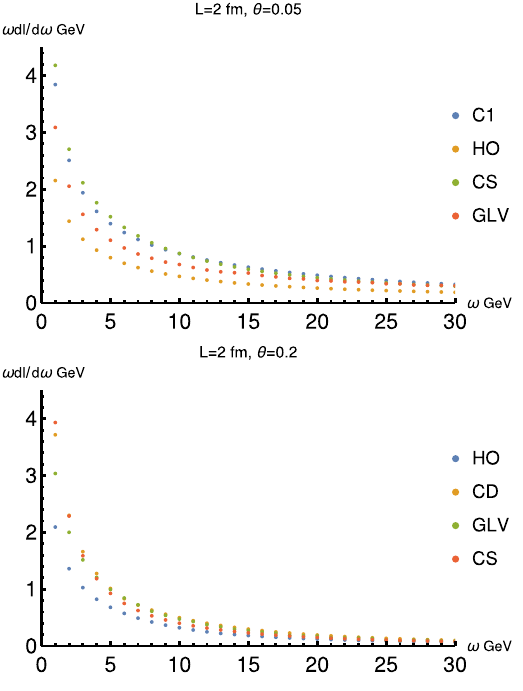
Fig. 1 The energy loss in the leading order in α s for L = 2 fm for dif- ferent values of θ as a function of the radiated gluon energy ω , divided by α s C F for different parametrizations of the substruction momentum Q ( ˆ q ,ω,θ) .Wedepicttheresultsforharmonicoscillatorapproximation (HO) and including the Coulomb contribution (HO + Coulomb) given